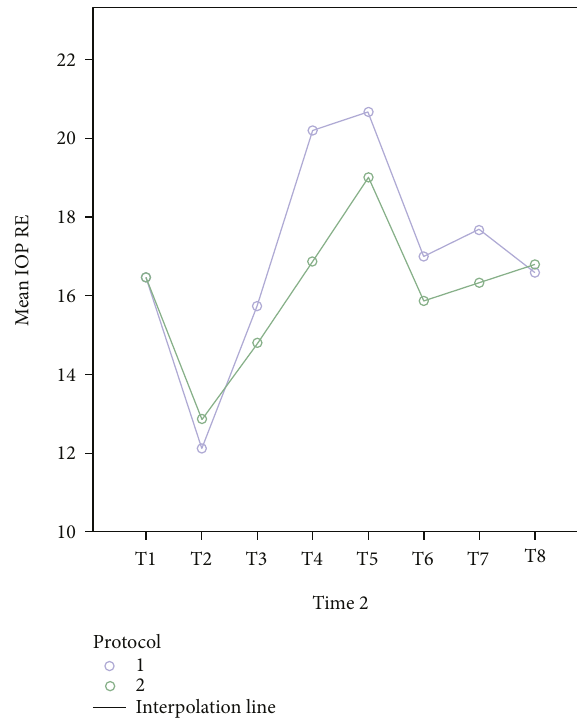
Figure 1: Mean changes of IOP in the left eye (LE) for the two fl uid management protocols. T4 and T5 refer to the time points at which patients were in the Trendelenburg position with CO the abdomen. 1: liberal fl uid protocol. 2: restrictive fl uid protocol.